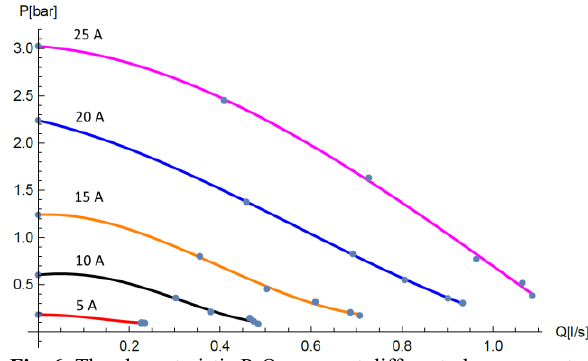
Fig. 6. The characteristic P-Q curves at different phase currents